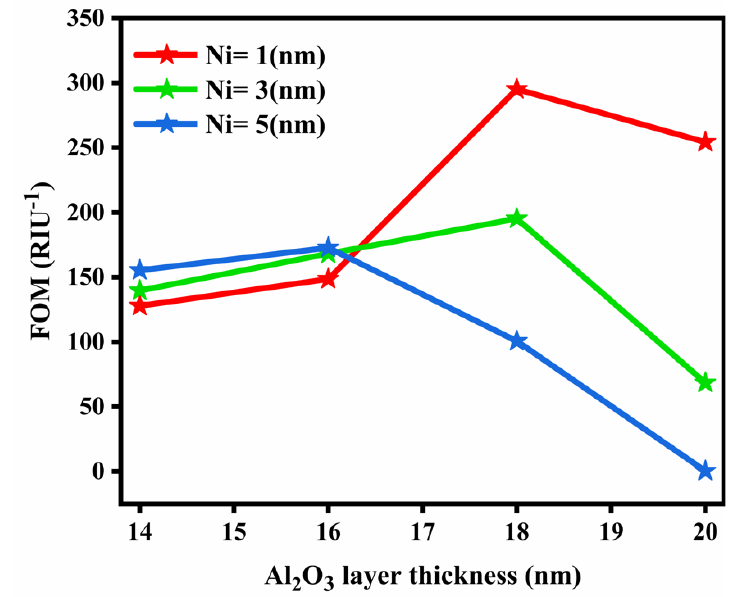
Figure 4. Variation of FOM vs. different layer thicknesses of Al 2 O 3 .